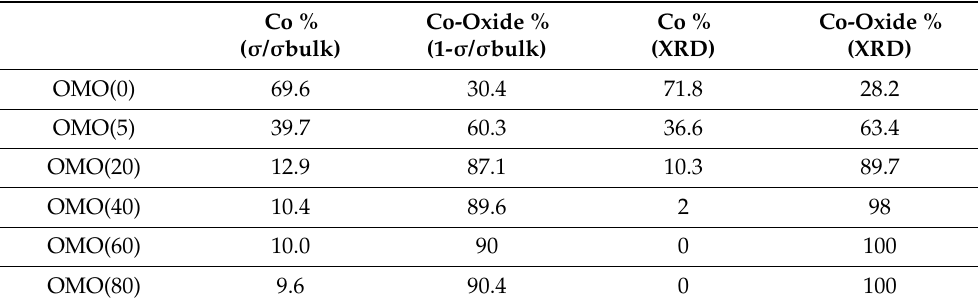
Figure 2. Evolution of the Phase Ratio with Respect to Oxidation Time in the OMO-Series. The con- necting lines are to aid visual tracking of the phase variations. Table 1. Summary of compositional and structural parameters extracted from magnetometry and XRD for the OMO-series. σ denotes saturation magnetization.